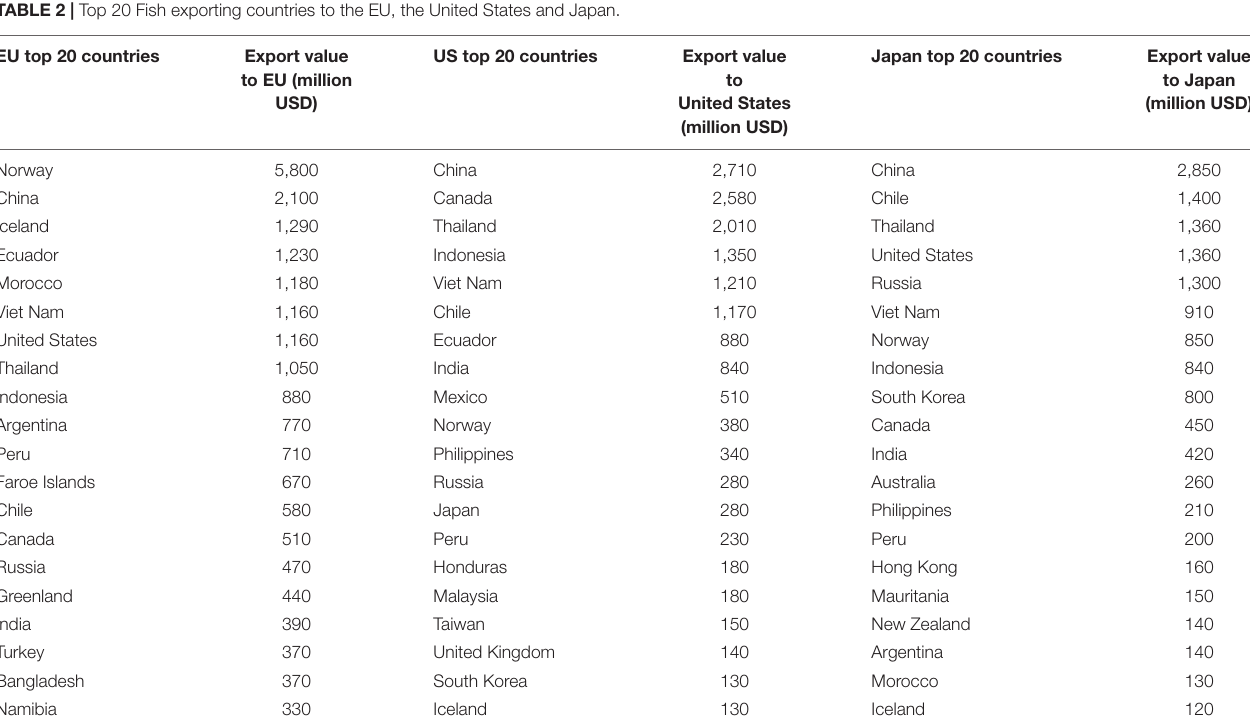
TABLE 2 | Top 20 Fish exporting countries to the EU, the United States and